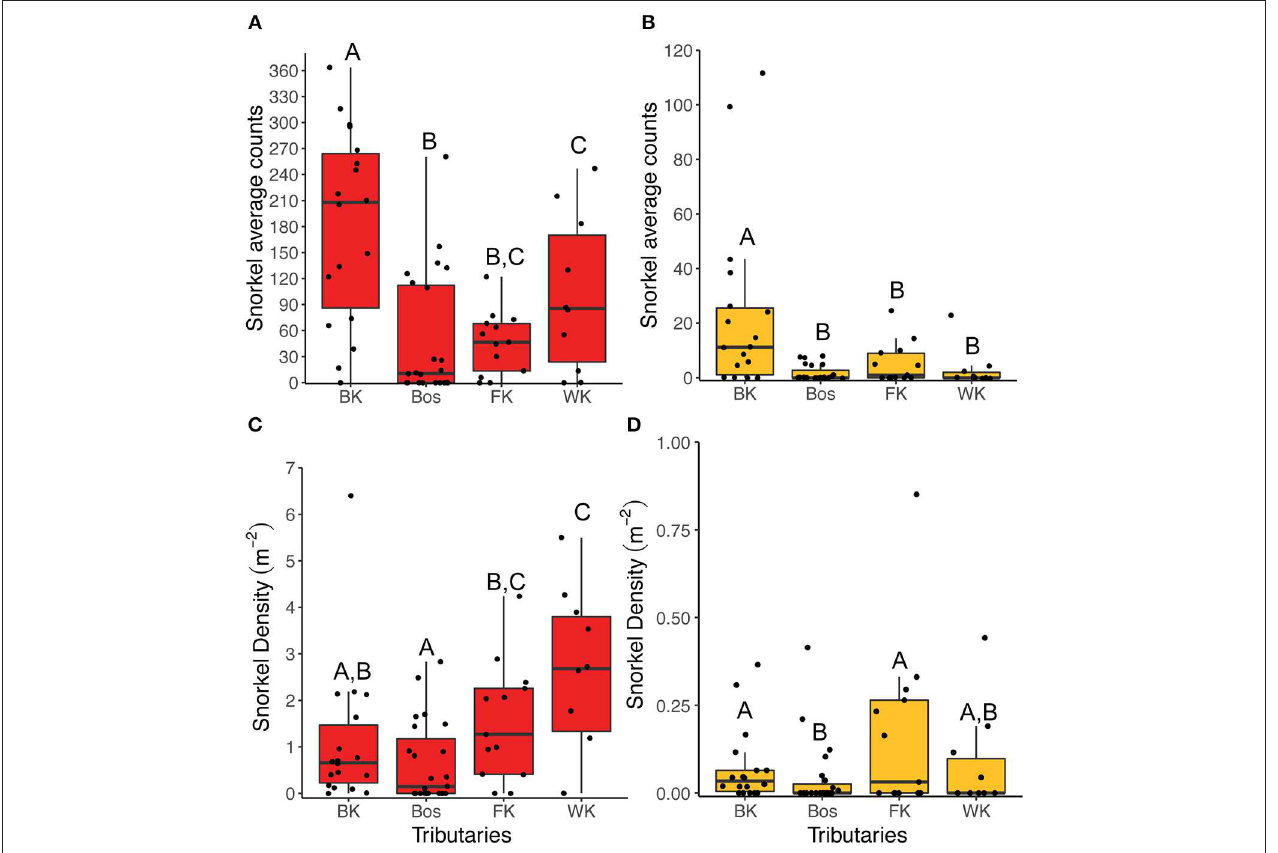
FIGURE 6 | Boxplots of the snorkel abundance data collected for redfins (red) and Cape Kurper (yellow) at each tributary. The snorkel average counts for (A) redfins, and (B) Cape Kurper. The snorkel densities (m − 2 ) for (C) redfins, and (D) Cape Kuper. BK is the Blindekloof, Bos is the Bos river, FK is the Fernkloof, and WK is the Waterkloof. Different letters above boxplots represent significant differences ( p < 0.05) from the post-hoc Dunn’s